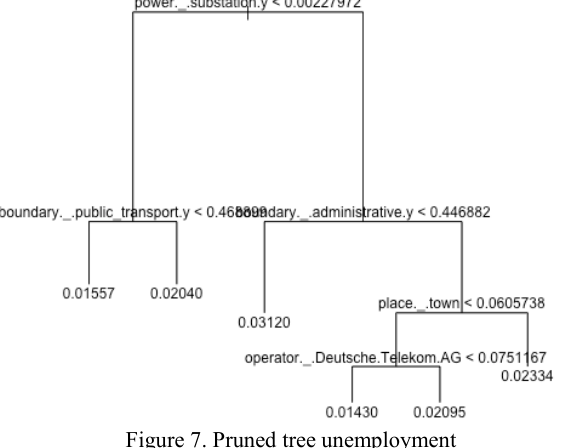
Figure 7. Pruned tree